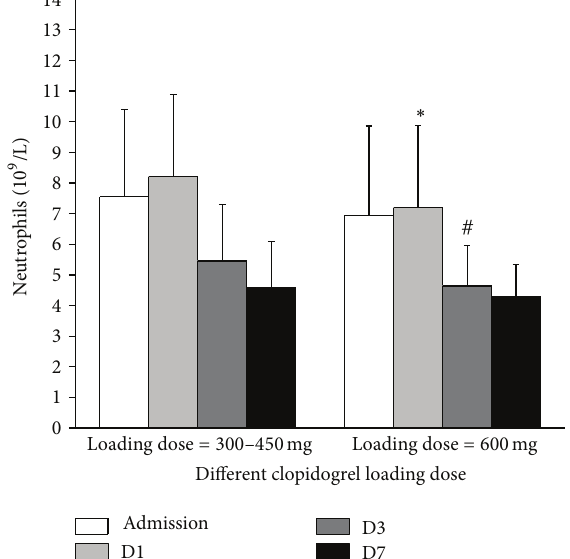
Figure 2: Comparison of neutrophil between different clopidogrel loading doses (low clopidogrel loading dose: 300–450 mg, 𝑛 = 259 ; high clopidogrel loading dose: 600mg, 𝑛 = 98 ) at different time points during the first week ( 𝑛 = 357 ). ∗ Represents 𝑃 < 0.05 compared with low clopidogrel loading dose (300–450 mg) on D1 and # represents 𝑃 < 0.05 compared with low clopidogrel loading dose (300–450 mg) on